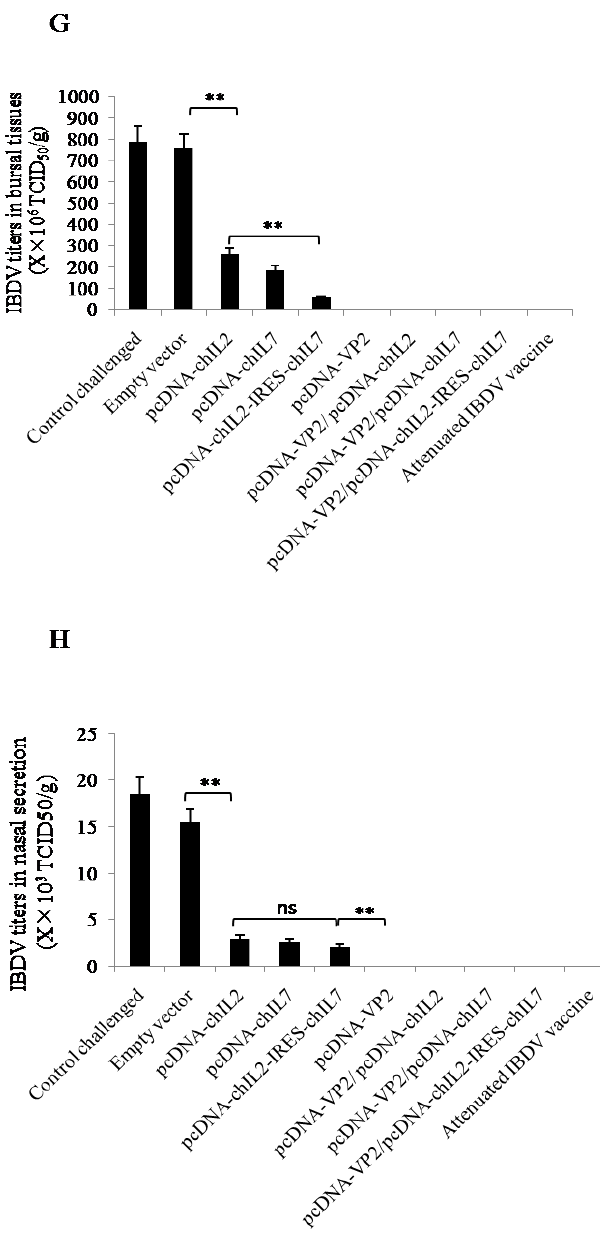
Figure 6. Protective effects of different DNA vaccines on IBDV-challenged chickens. ( A ) Survival rates, analyzed with the Kaplan–Meier survival curve. ( B ) Bursal body ratio, calculated by (bursal weight / body weight) × 1000 and presented as the mean ± SD from each group. ( C ) Bursal lesion scores, disigned from 0 to 5 according to the severity of bursal involvement at time of euthanasia (0: no lesion; 1: slight change, 2: scattered or partial bursal damage, 3: 50% or less follicle damage, 4: 51–75% follicle damage and 5: 76–100% bursal damage). ( D ) Histopathological BF lesion in different groups. a–k, control unchallenged, control challenged, empty vector, pcDNA-chIL-2, pcDNA-chIL -7, pcdNA-chIL-2-IRES-chIL-7, pcDNA-VP2, pcDNA-VP2/pcDNA-chIL-2, pcDNA-VP2/pcDNA- chIL-7, pcDNA-VP2/pcDNA-chIL-2-IRES-chIL-7, and attenuated IBDV vaccine, respectively. ( E ) Bursal lesion score criteria based on bursal histopathological characteristics. a–e, bursal lesion score 0, 1, 2, 3, 4, and 5, respectively. ( F ) Protective efficacy, defined by the number of chickens with histopathlogical BF lesion score 0 and 1/the number of chickens. ( G ) and ( H ) IBDV titers in bursal tissues and nasal secretion, respectively. Values are expressed as mean ± SD. ** p < 0.01, * p < 0.05, NS, no significance.